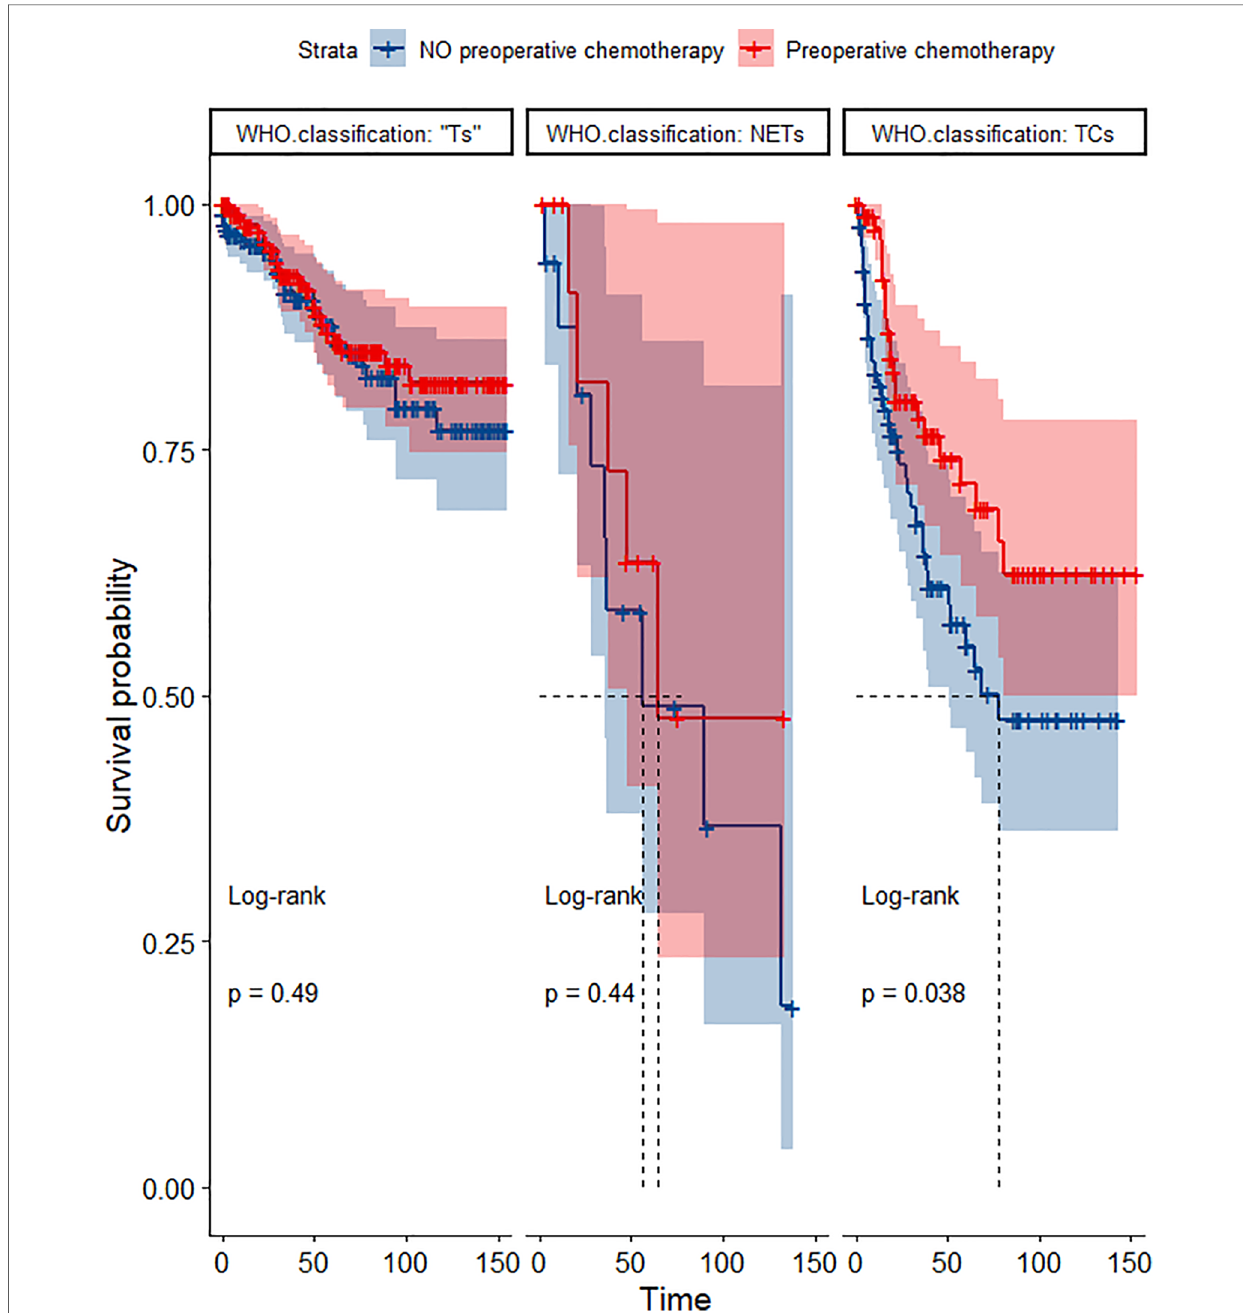
FIGURE 12 Survival curves of CSS in the POCT and no POCT groups in patients undergoing surgery for TETs in different WHO classi fi cation groups after propensity